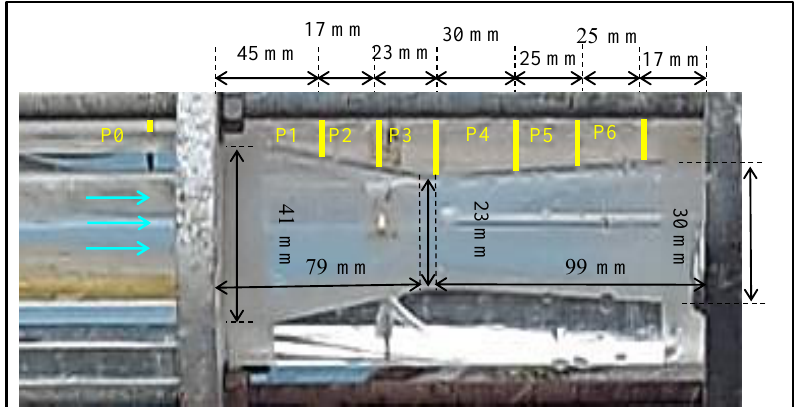
Figure 2. The experimental system.